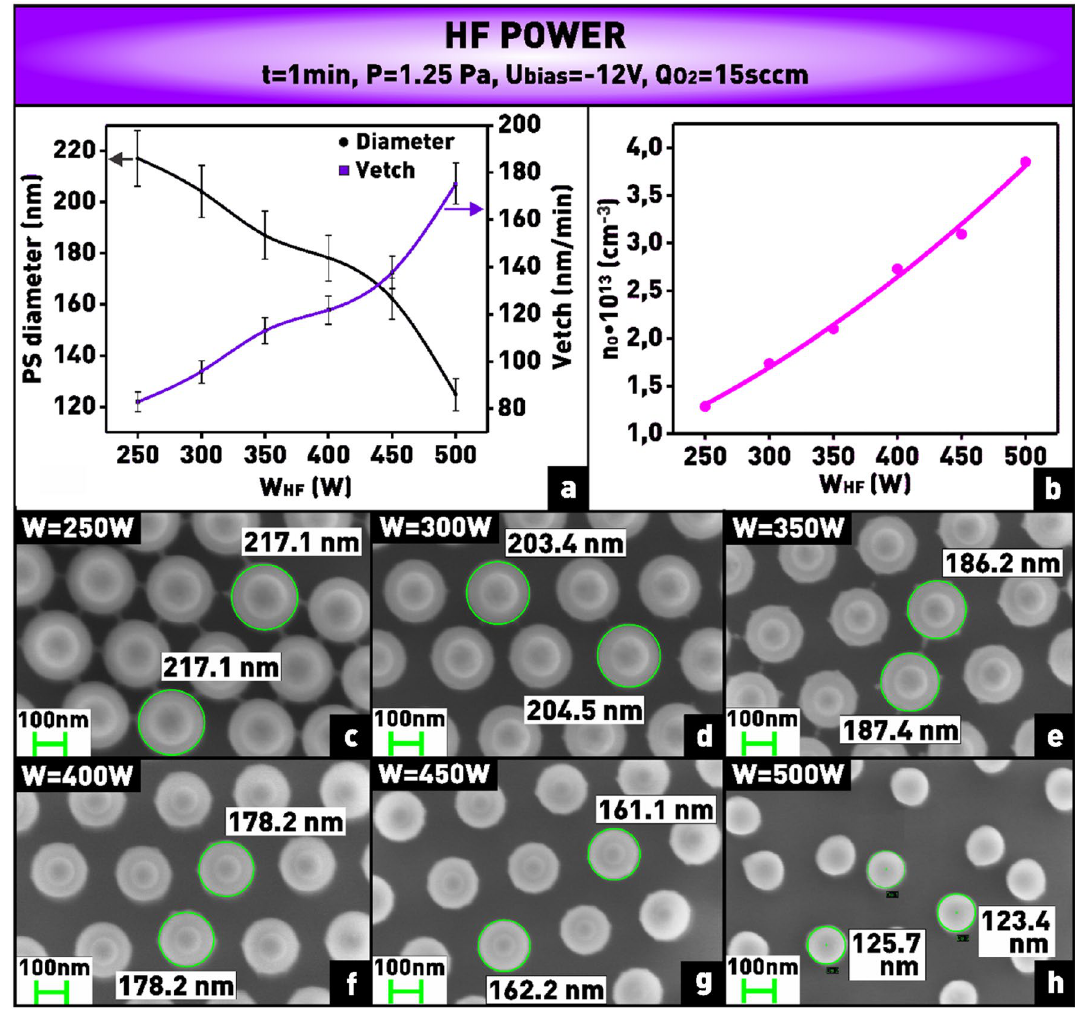
Figure 9. (a) Plot of dependence of nanosphere diameter and etching rate on applied HF power; (b) plot of dependence of oxygen atom concentration on applied HF power; (c–h) microphotographs of nanosphere mask obtained at varying HF